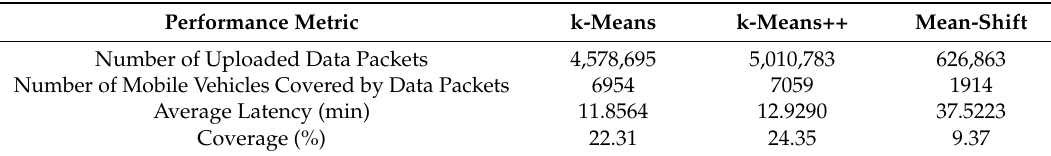
Table 2. Experimental results of LCODC